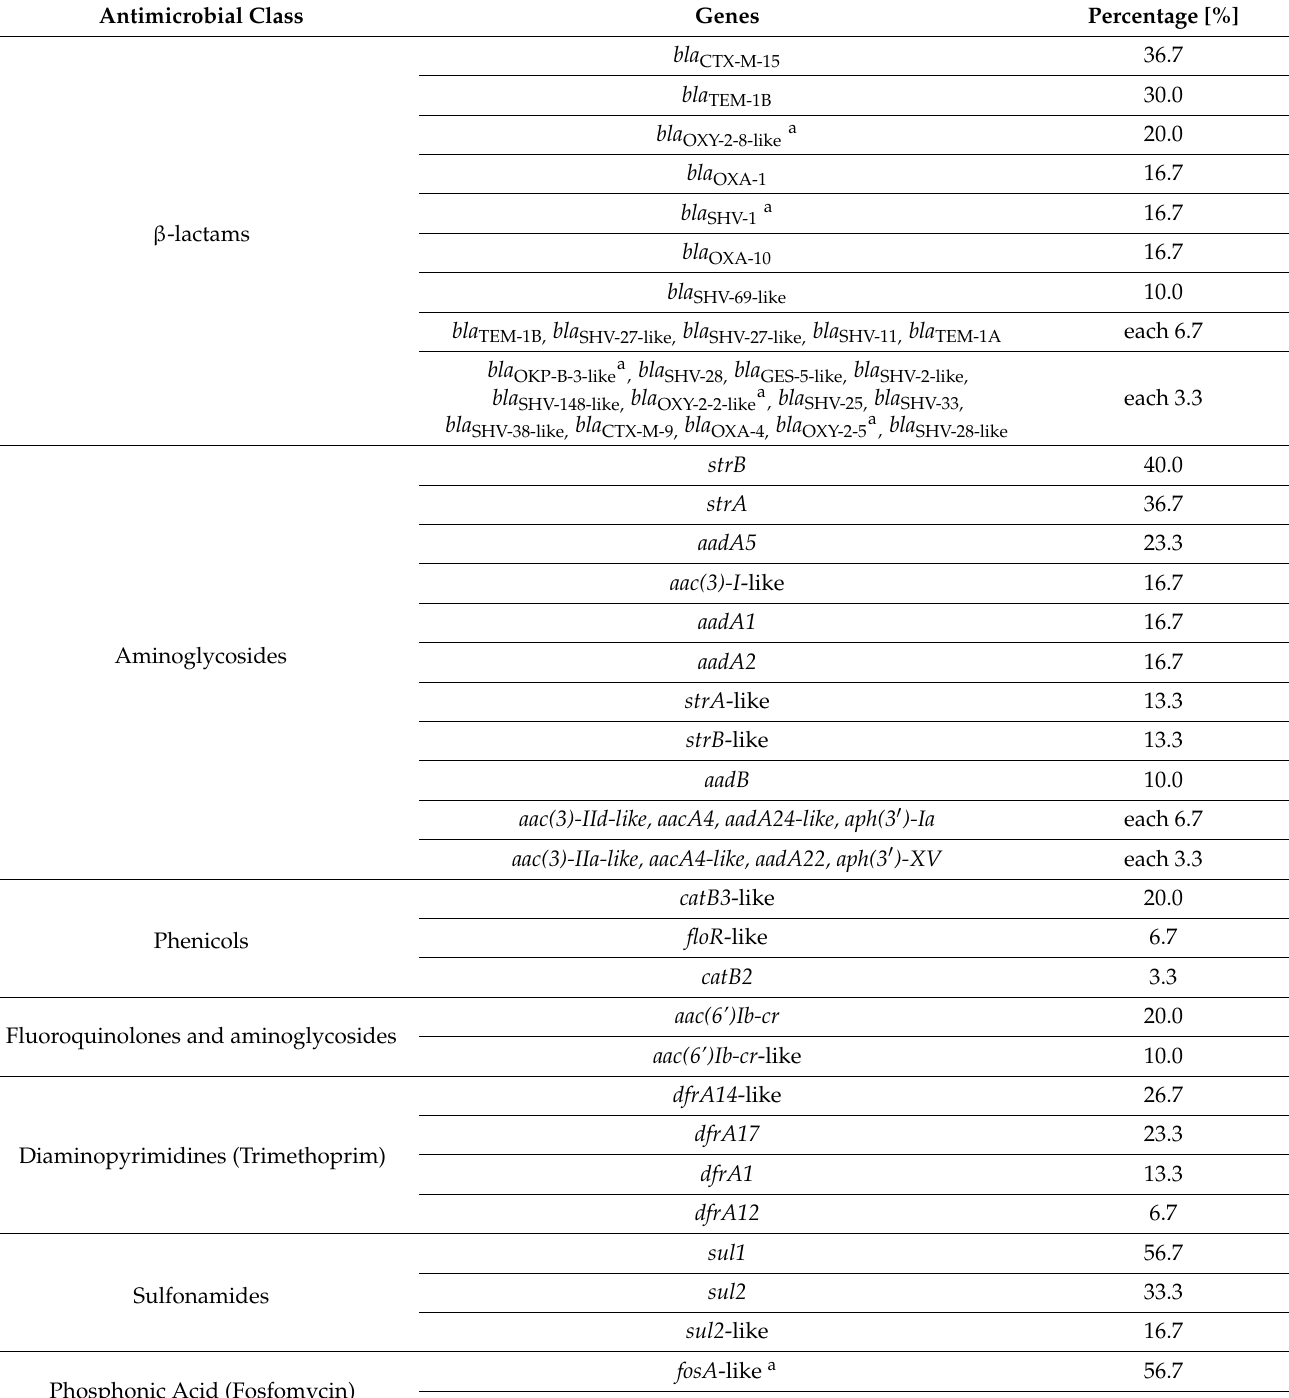
Table 2. Prevalence of antibiotic-resistance genes detected in carbapenem-resistant Klebsiella spp. isolates recovered from municipal WWTPs and their receiving water bodies as well as from process waters of poultry and pig